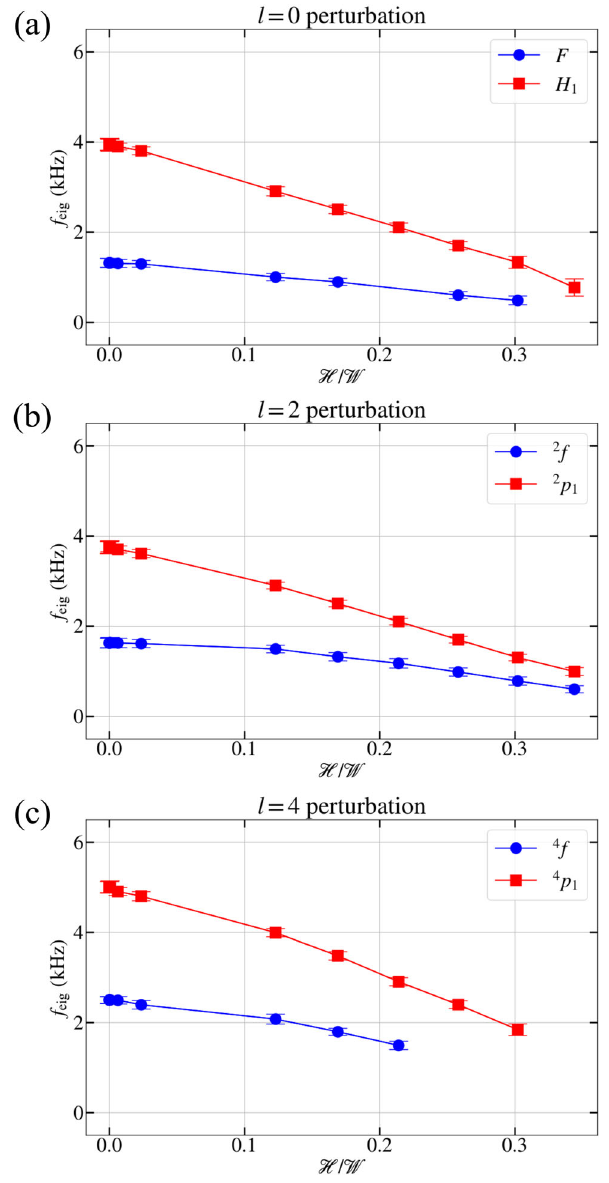
Fig. 2 Effects of magnetization on eigenfrequencies of oscillation modes. Eigenfrequencies f eig of the excited oscillation modes are plotted against the magnetic to binding energy ratio H = W of the NS model, if l = 0 ( a ), l = 2 ( b ), and l = 4 ( c ) perturbations are applied respectively. The FWHMs in the parabolic interpolations of FFT peaks are taken as the error bars for f eig . For all the modes, the data points at H/W ~ 0 (corresponding to REF-T1K5 models) show a nearly horizontal trend, even though these models span a few orders of magnitude in H = W and can achieve a maximum fi eld strength of 10 15 − 17 G. This implies magnetization has negligible effects on stellar oscillations for NSs with H = W ≲ 10 (cid:1) 2 . However, f eig noticeably decreases with H = W for H = W ≳ 10 (cid:1) 1 in general, and as explained in the caption of Table 1, the expected higher-order hexadecapole ( l = 4) modes are suppressed or even disappear in the most magnetized models under l = 4 perturbation. Hence, we can see that stellar oscillations are signi fi cantly suppressed by stronger magnetization for NSs with H = W ≳ 10 (cid:1) 1